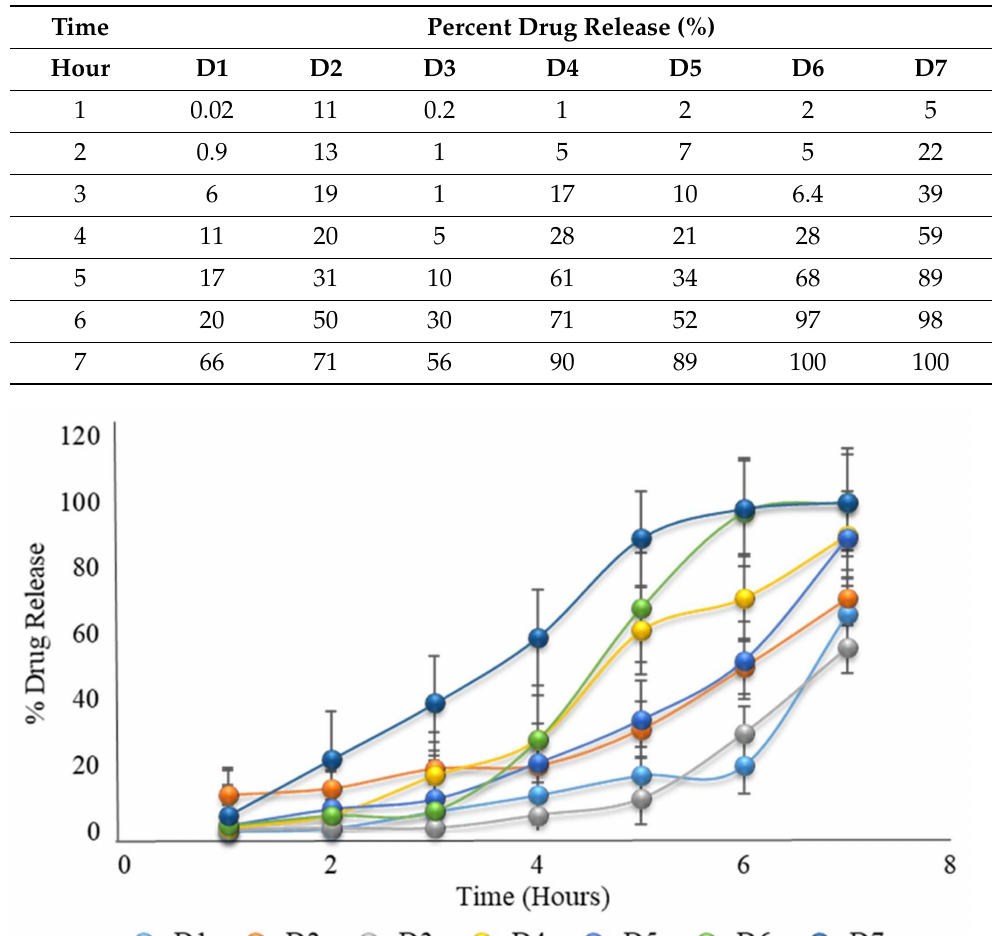
Table 8. The in vitro dissolution of formulations D1 to D7 (the first 2 h in an acid medium of pH 1.2, and then in a phosphate buffer medium of pH 6.8).